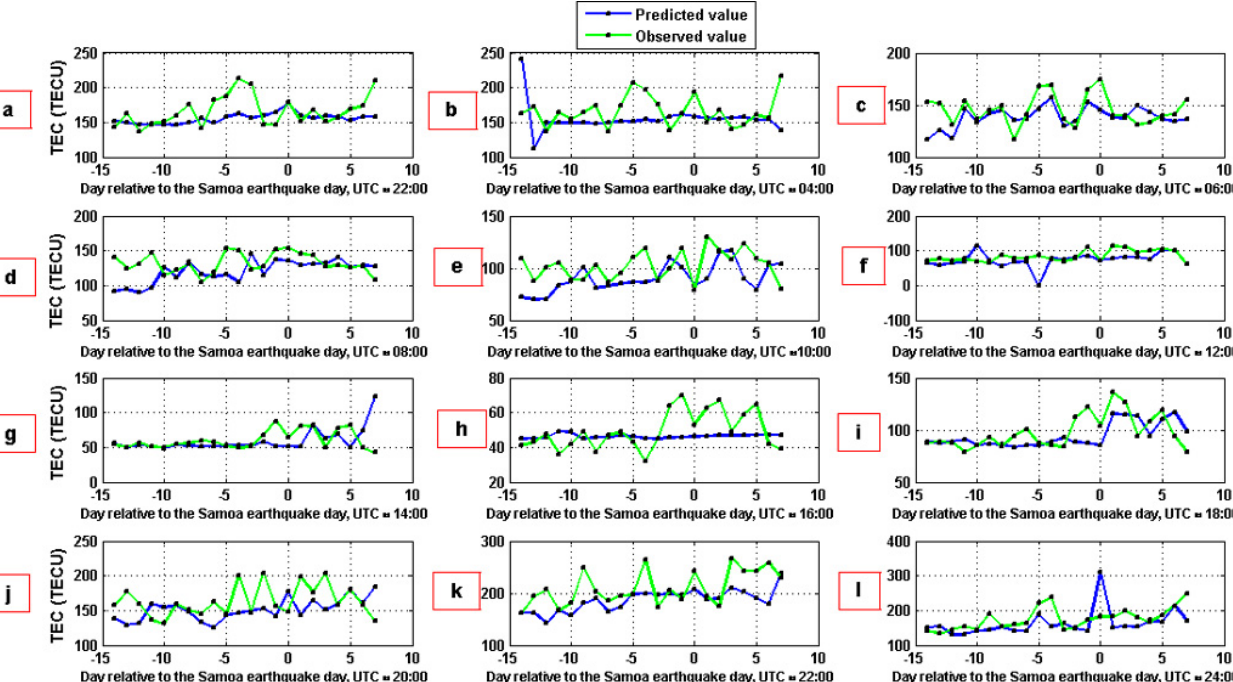
Fig. 10. Variations of the observed (green curve) and predicted (blue curve) TEC values on days selected as testing set at different universal times. The x-axis represents the day relative to the Samoa earthquake